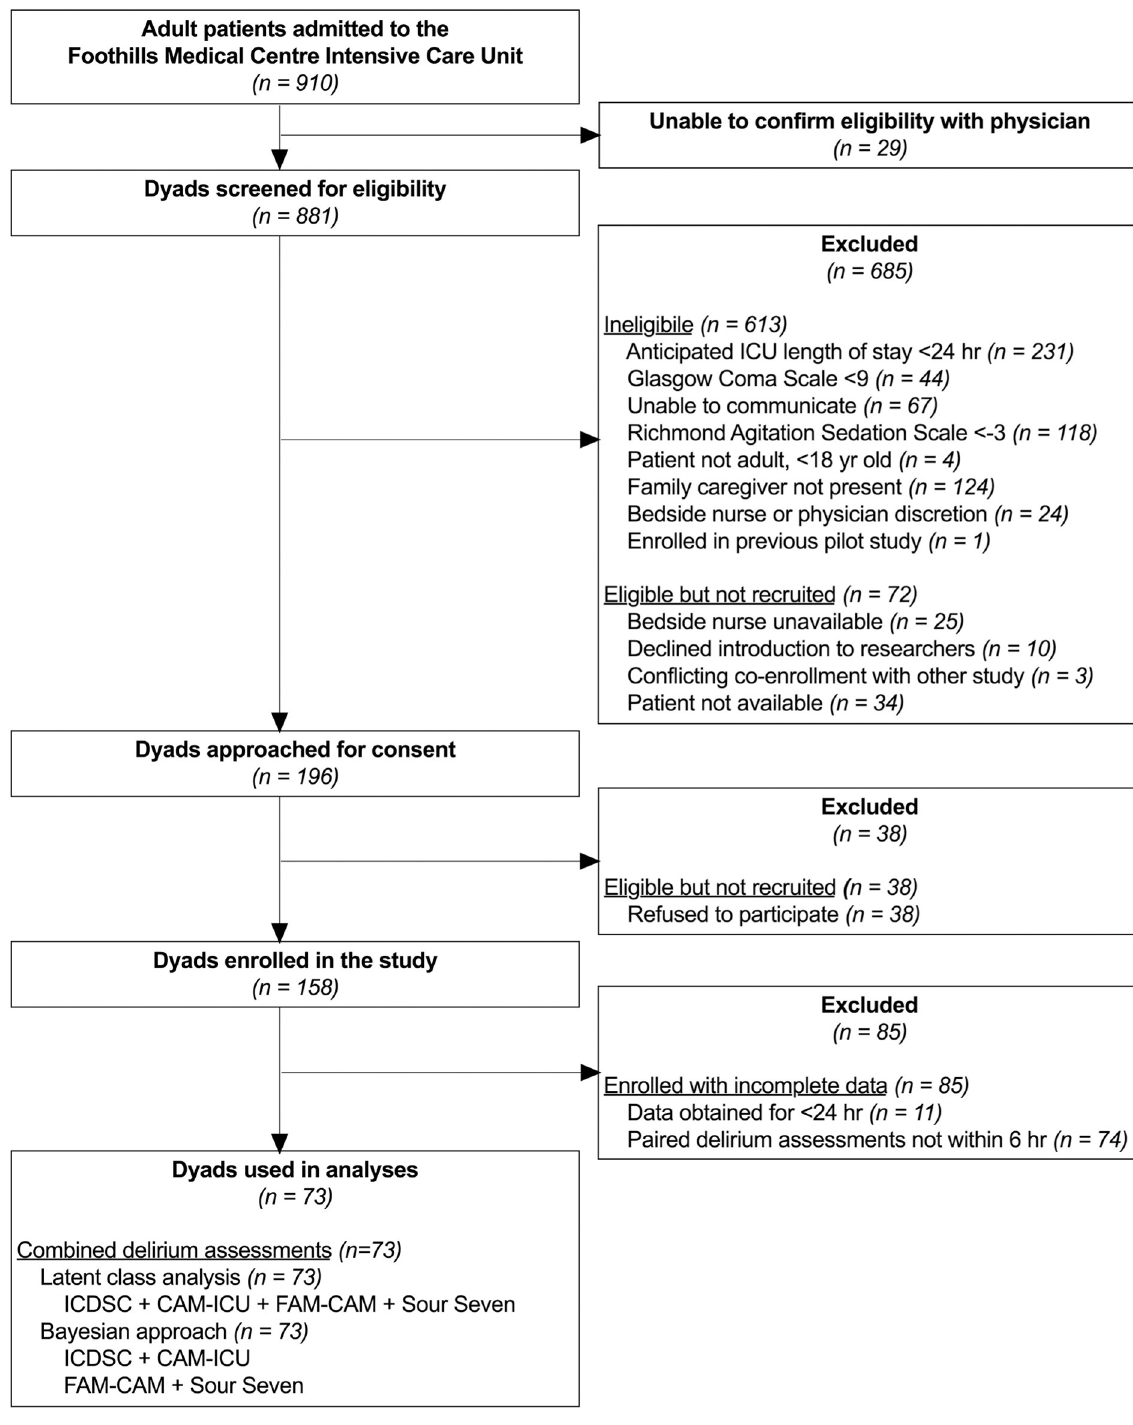
Fig 1. Participant flow